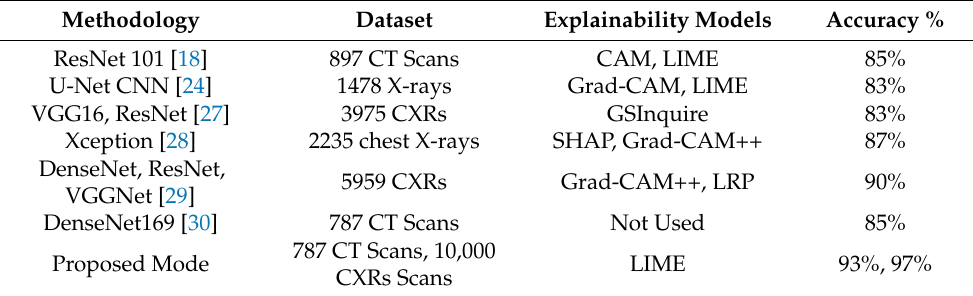
Table 1. Comparative analysis of existing explainable artificial intelligence (XAI) and classification models for lung